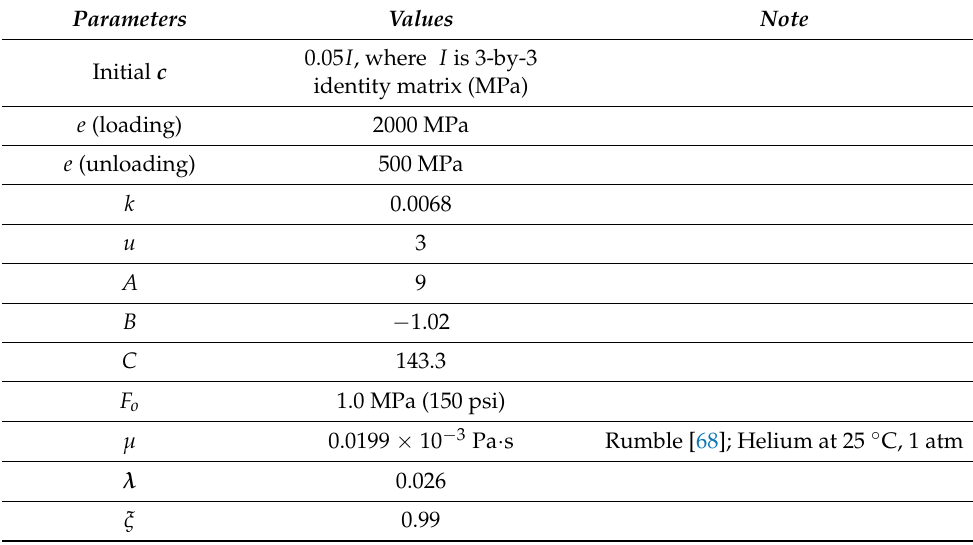
Table A6. Values of different parameters for sample 3 (test 3).